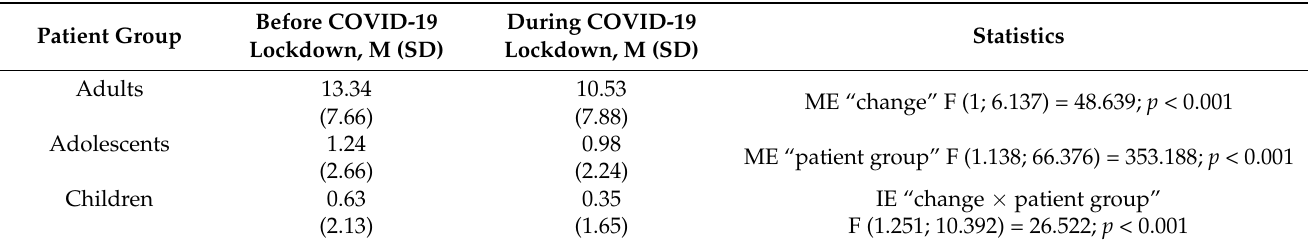
Table 2. Numbers of patients treated before vs. during the COVID-19 lockdown per patient group.